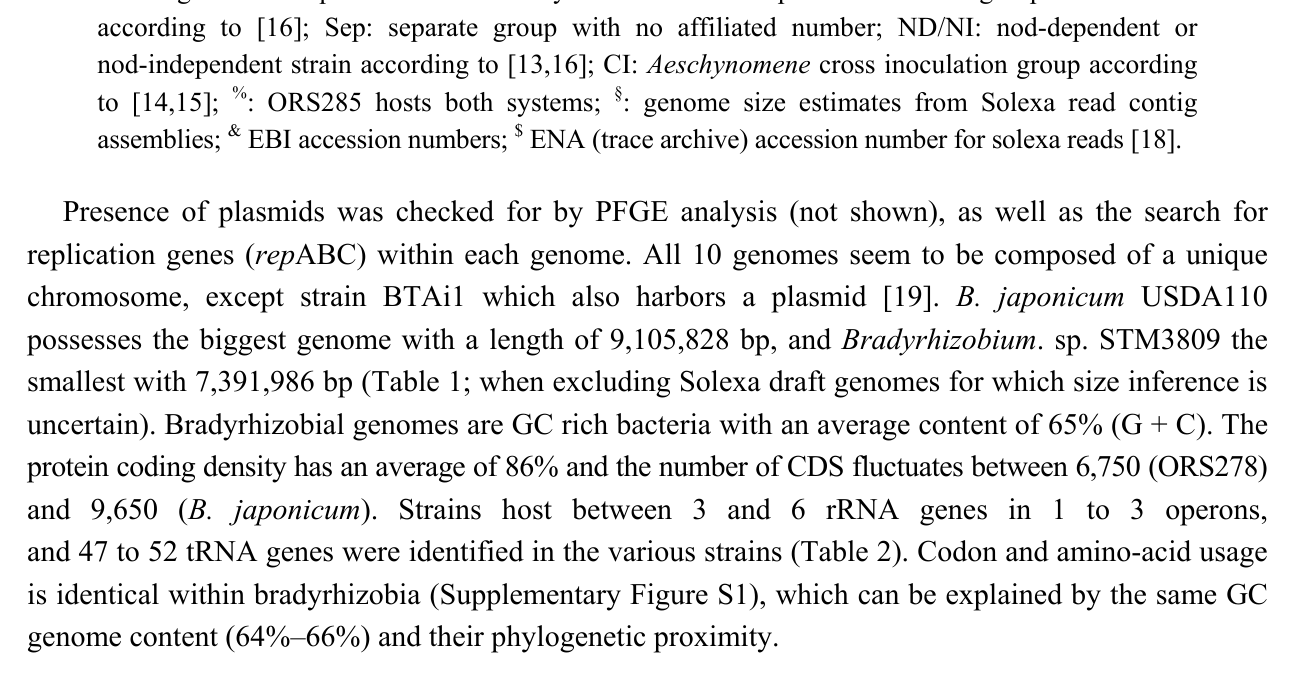
Table 2. Genomic features of bradyrhizobial